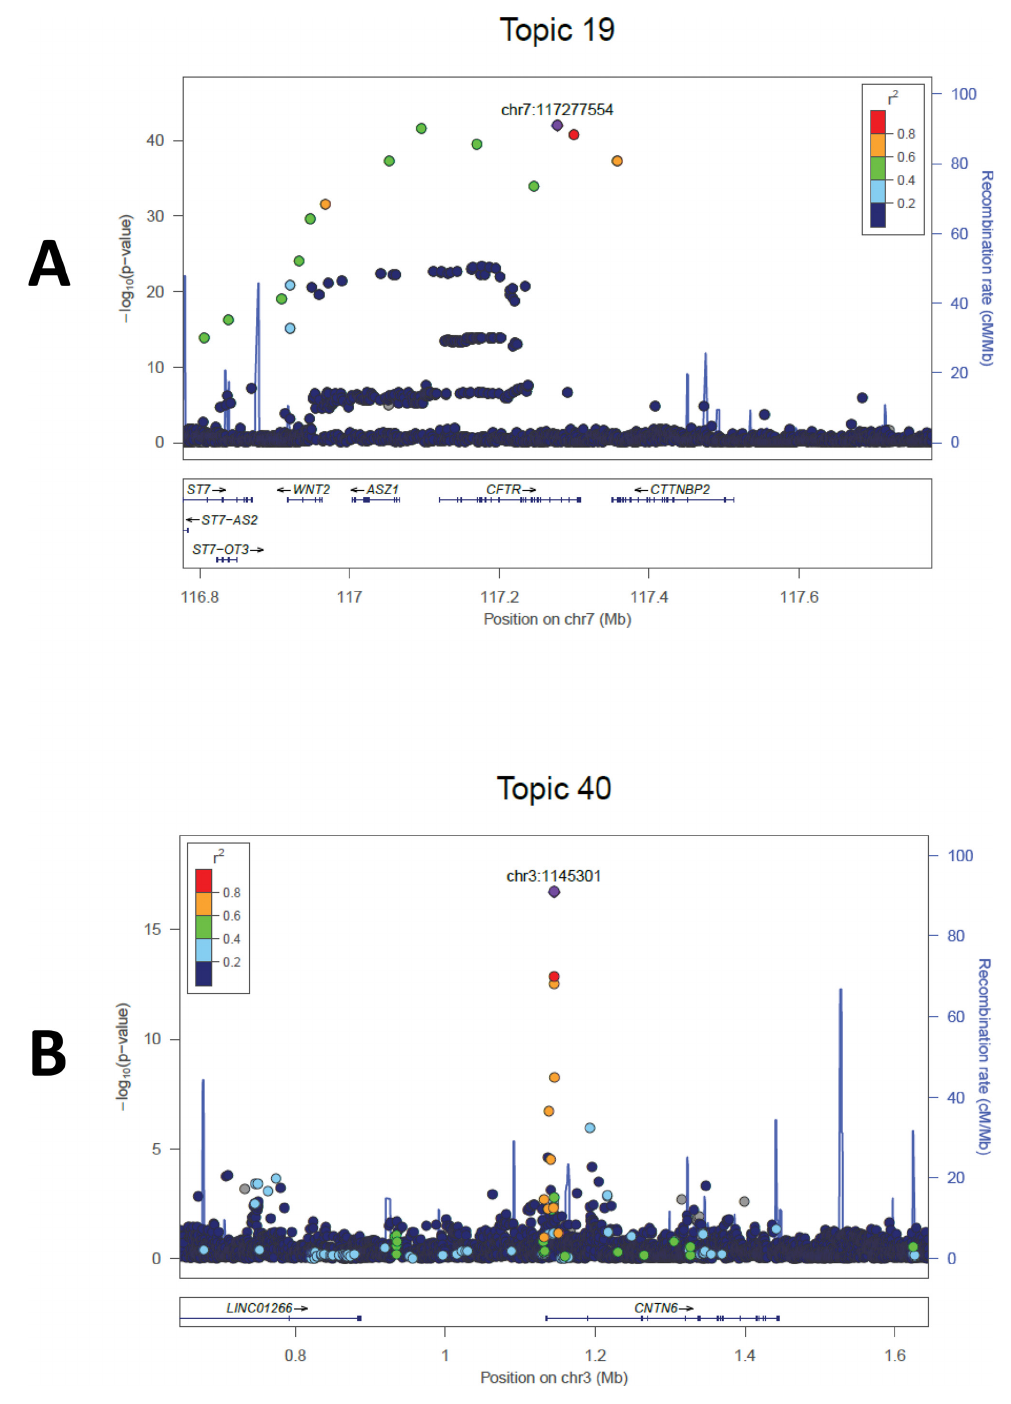
Figure 2. Locus plots for two example topics: (A) pulmonary disease/cystic fibrosis-plus and (B)